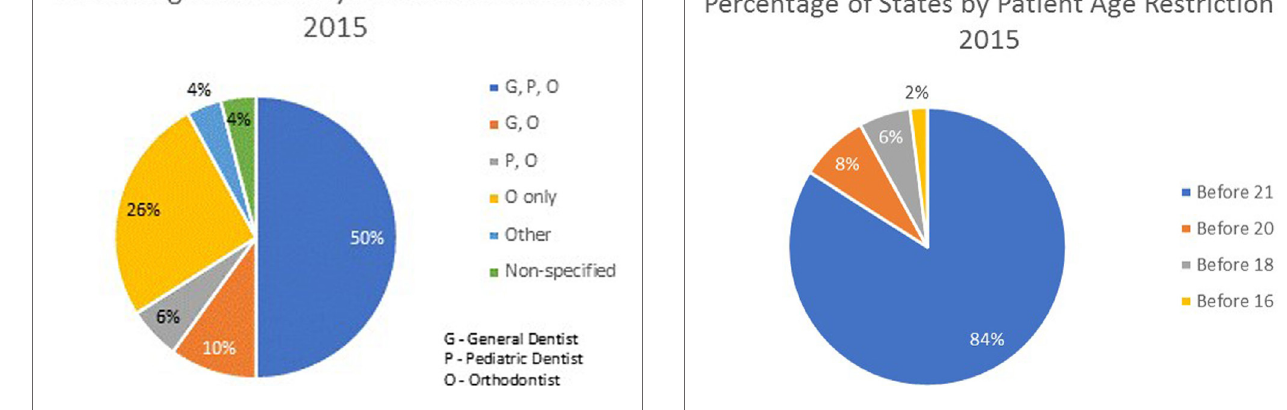
FigUre 1 | Percentage of states by provider restrictions 2015. FigUre 2 | Percentage of states by age restriction